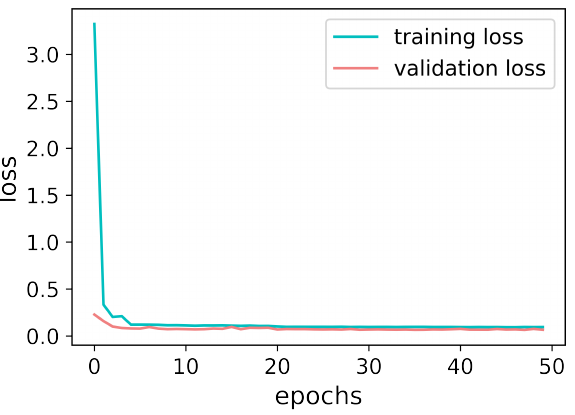
Figure 20. Loss in training using the proposed TL-Seq2Seq method (Wang76 well).